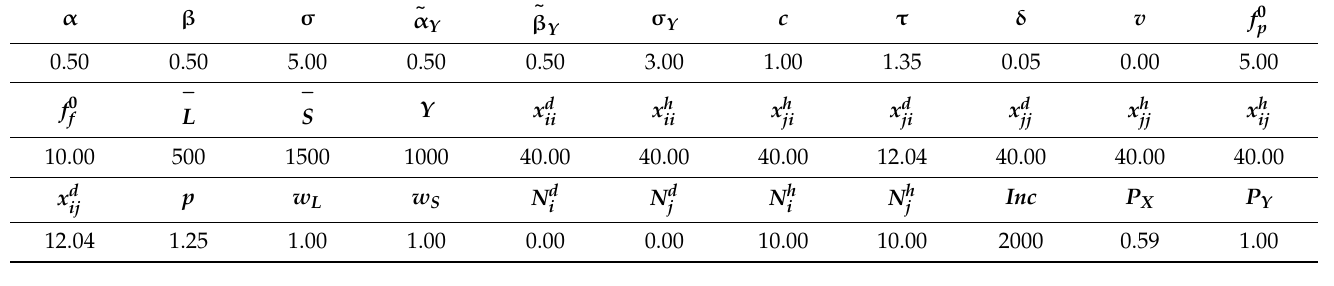
8 of 15 Table 1. Benchmark parameter and variable values.